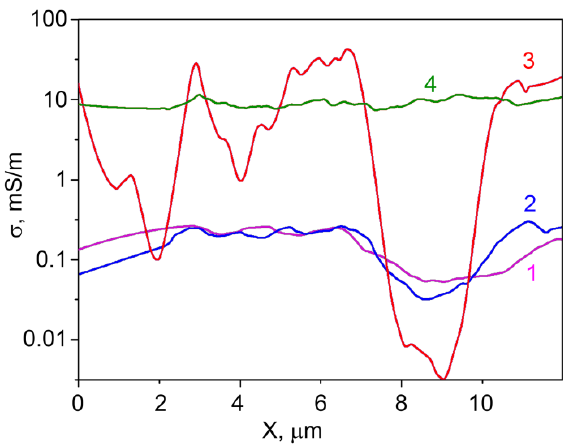
Figure 7. Distribution of averaged specific conductivity σ along the SSRM image cross-sections of the samples containing 1.0–1.3 at.% Ga and (1) 0 at.%, (2) 0.74 at.%, (3) 3.4 at.%, (4) 5.9 at.% In.